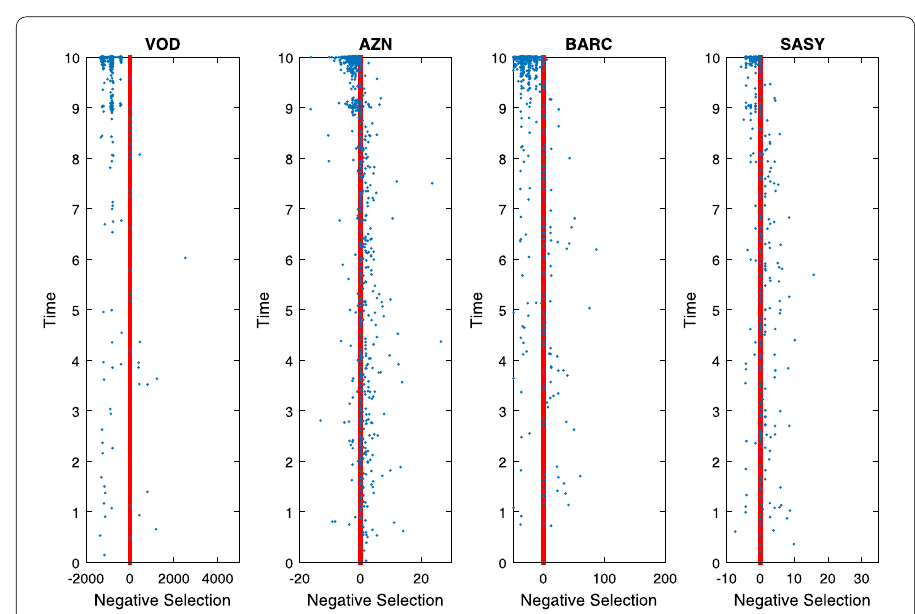
Figure 6 The distribution of Cancel Time and Fill time